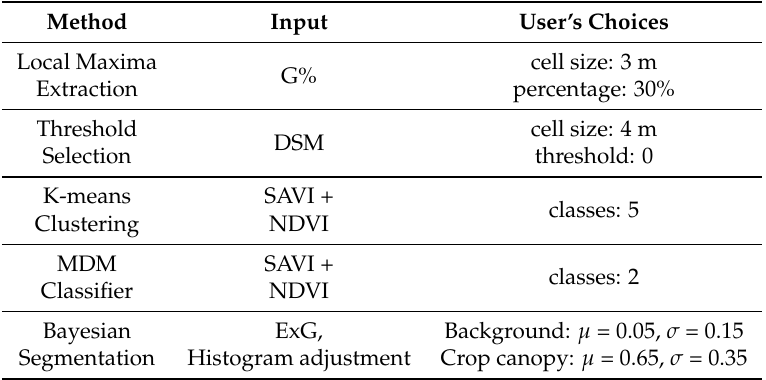
Table 9. Tomato field site: parameters for the best results of each detection